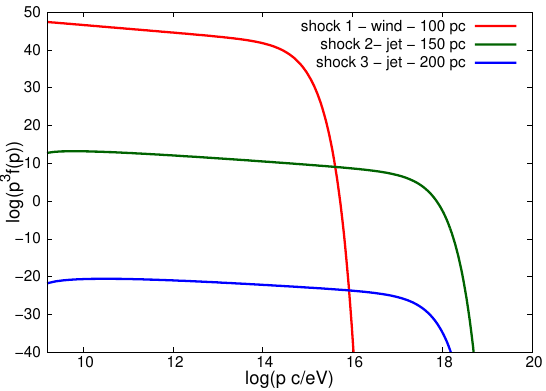
Figure 8. Particle distribution injected by the wind shock at z = 100 pc, and the distribution after reacceleration in the jet shocks at 150 pc and 200